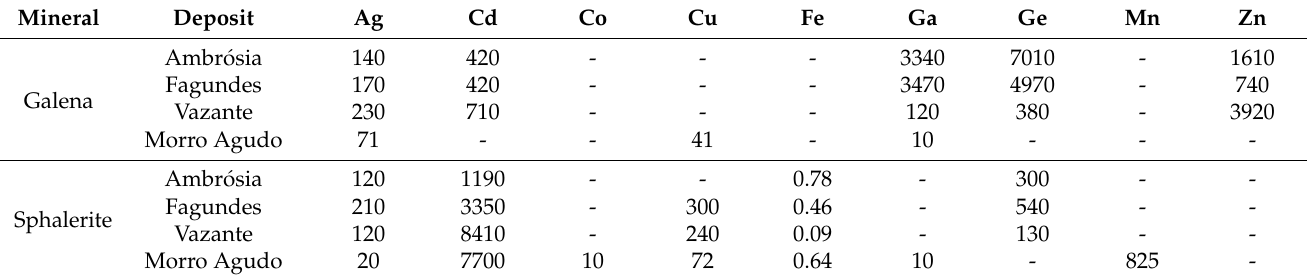
Table 7. Previously reported mean trace element compositions (Fe in wt.% and other elements in ppm) of sphalerite and galena from the Fagundes, Ambr ó sia, and Vazante deposits. Data from Monteiro et al. [6] and references